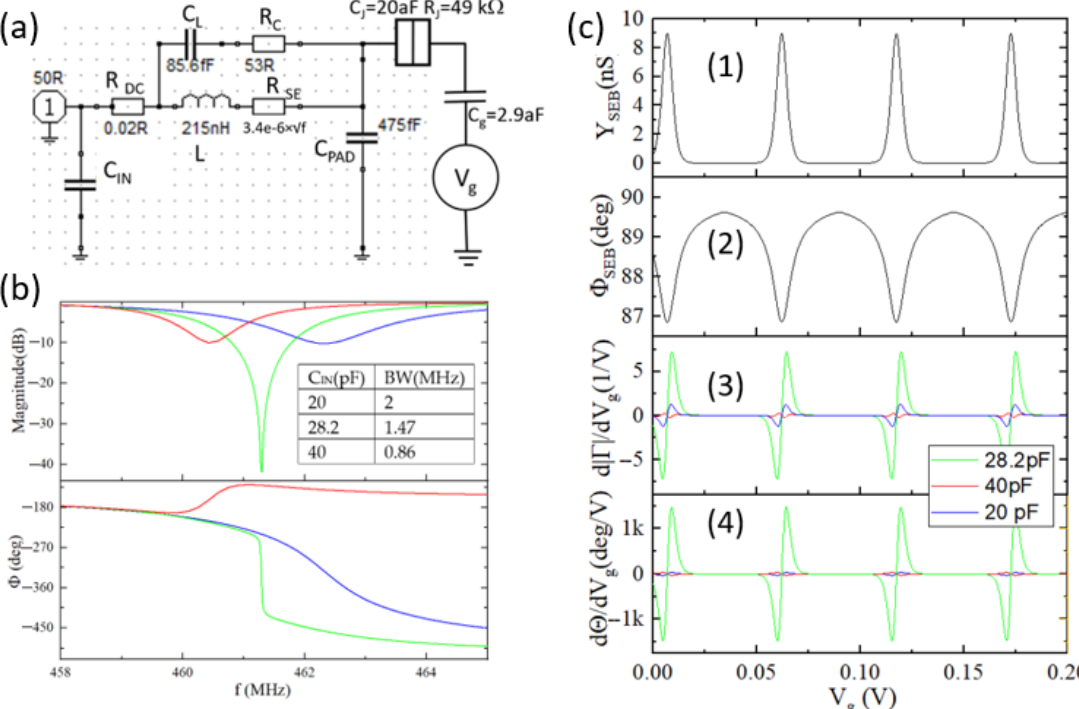
Figure 6. ( a ) Circuit diagram of a Π -MN used in measurements. C IN is a tuning element; C PAD is a bond pad capacitor; horizontally places elements between C In and C PAD represent the realistic inductor at low temperature; a single SEB with parameters similar to the experiment is attached to a bond pad. ( b ) Magnitude and phase response of the MN for three different values of C IN indicated in the plot: blue, 20 pF; green, 28.2 pF; and red, 40 pF. Inset table represents − 3 dB small signal gate modulation bandwidth calculated in ADS software. ( c ) Simulated response of the network with an SEB with parameters shown in subplot ( a ) at T = 2.4 K: Oscillations in magnitude ( c1 ) and phase ( c2 ) of SEB admittance vs. gate bias V g calculated for carrier frequencies corresponding to the minima in the magnitude of the reflected signal in subplot ( b ). Derivatives d | Γ |/ dV g ( c3 ) and d Θ / dV g ( c4 ) of oscillations in the reflected signal.